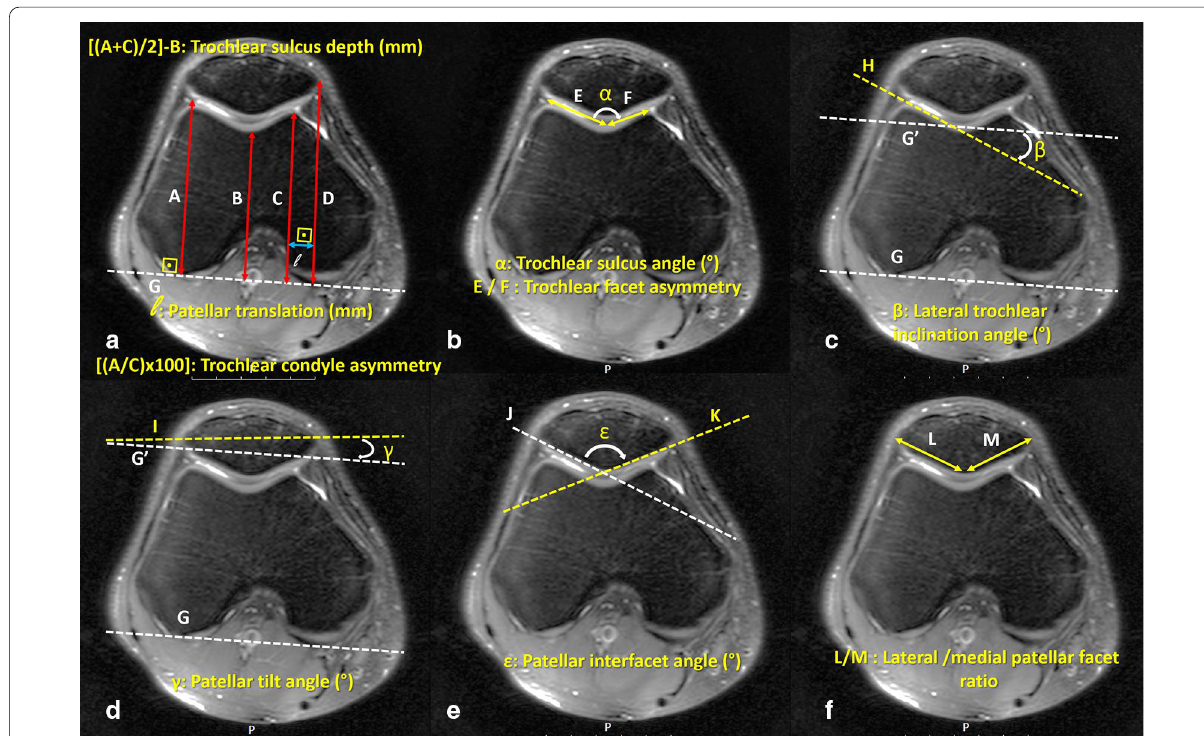
Fig. 3 a Measurement of trochlear sulcus depth, patellar translation, and trochlear condyle asymmetry. First, posterior condylar axis was drawn (line G). Perpendicular lines from the highest points of the medial (line A) and lateral (line C) facets, and the deepest point (line B) of the trochlear groove were drawn. Finally, the perpendicular distance from the posterior condylar axis to the medial corner of the patella (line D) was drawn. Trochlear sulcus depth was calculated as [( A C )/2] B and recorded in millimeters. Patellar translation was measured as the perpendicular + − distance between line C and line D and recorded in millimeters. Trochlear condyle asymmetry was calculated as [( A / C ) 100%] and recorded as a × percentage. b Measurement of trochlear sulcus angle and trochlear facet asymmetry. Two parallel lines, one to the lateral facet of the trochlea (line E) and the second one to the medial facet of the trochlea (line F), were drawn. The angle ( α ) between these lines was measured as the trochlear sulcus angle. The ratio of the distance line E to line F was calculated as the trochlear facet asymmetry. c Measurement of lateral trochlear inclination angle ( β ) between the lateral trochlear slope (line H) and posterior condylar axis (line G). d Patellar tilt was defined as the angle ( γ ) formed between the transverse axis of patella (line I) and posterior condylar condyle line (line G). e Patellar interfacet angle was defined as the angle between the lateral patellar facet (line K) and medial patellar facet (line J). f The ratio of the lateral (line M) to the medial (line L) patellar facets was calculated. All measurement were performed on axial fat-saturated, proton-density-weighted